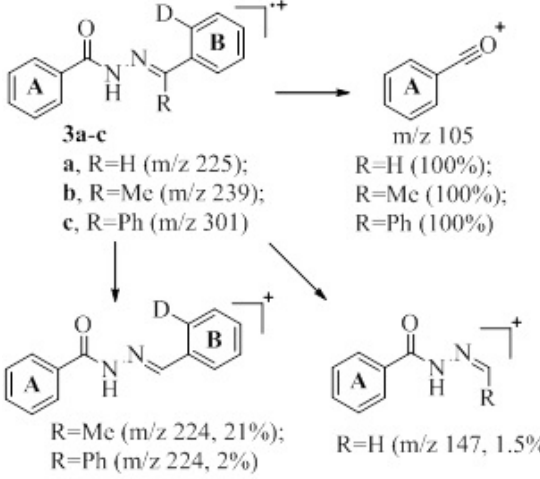
Figure 3 - Proposed mechanism for the fragmentation of 3a-c .